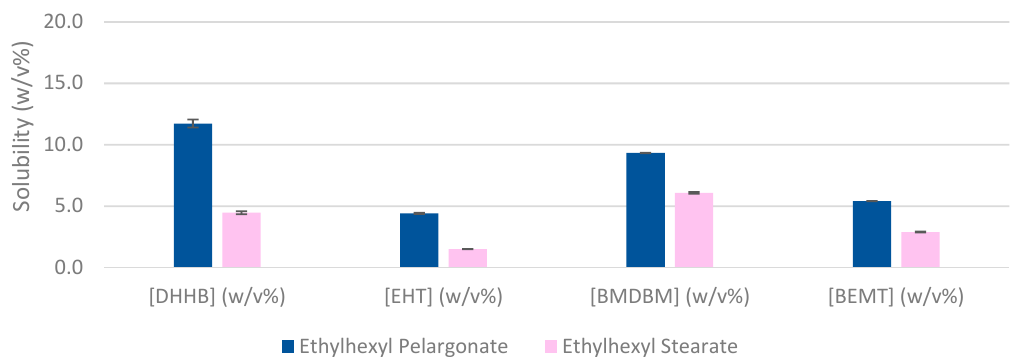
Figure 1. UV filter solubility of Ethylhexyl Pelargonate versus Ethylhexyl Isononanoate. When comparing the repercussions of the chain length in the solubility, Ethylhexyl Pelargonate and Ethylhexyl Stearate present equivalent results as the previous analysis; where the less voluminous has better solubility, in this case the shorter the molecule the higher capacity of solubilizing UV filters (Figure 2).